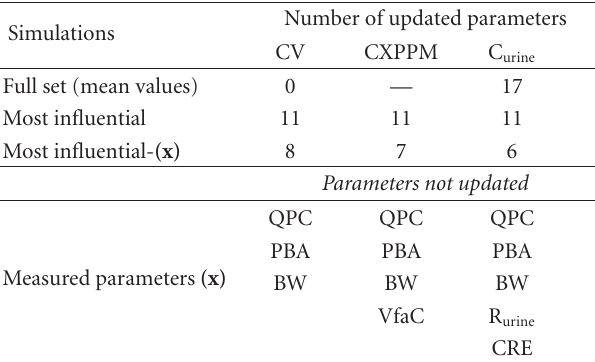
Table 3: Summary of